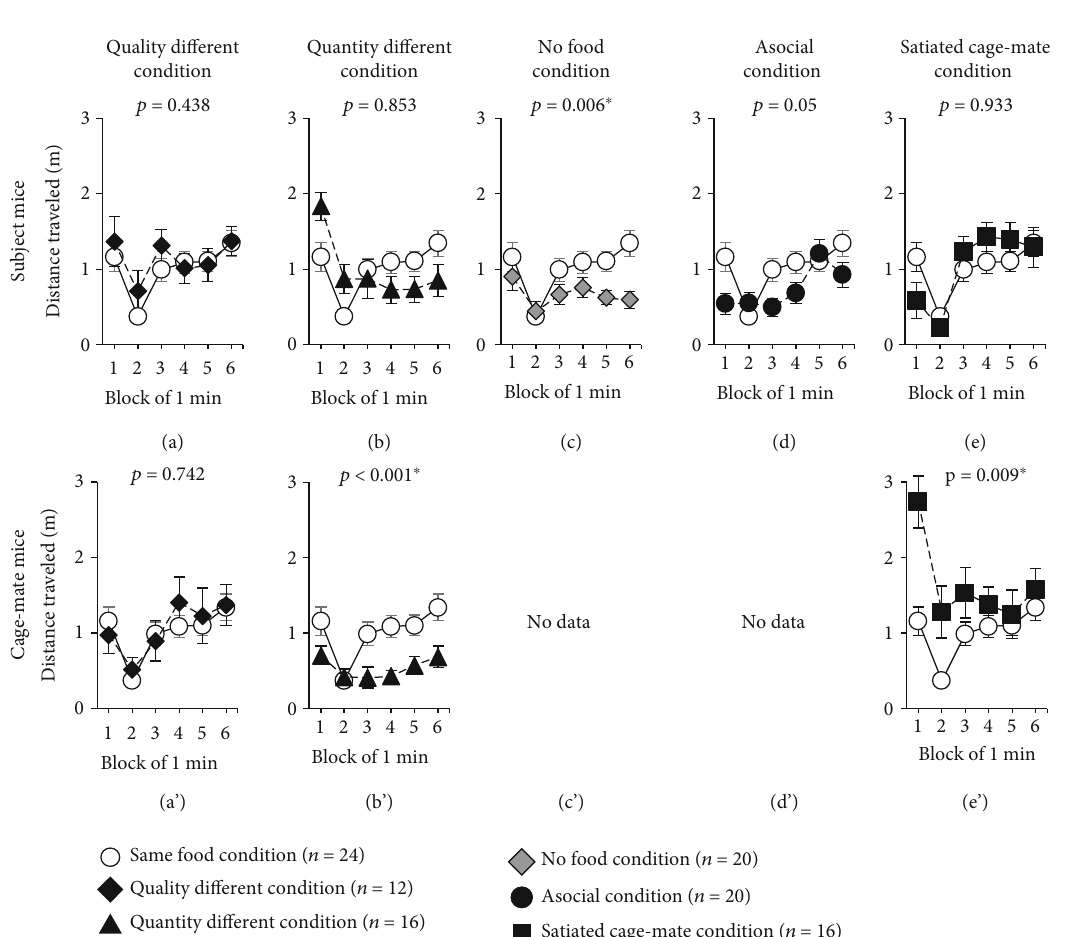
(Figure 4(a), F 1 , 30 = 16 : 870 , p < 0 : 001 , S5 Video). Time spent in the food area (Figure 4(b), F 1 , 30 = 5 : 551 , p = 0 : 025 ) was also signi fi cantly longer as compared to the no food condition test.